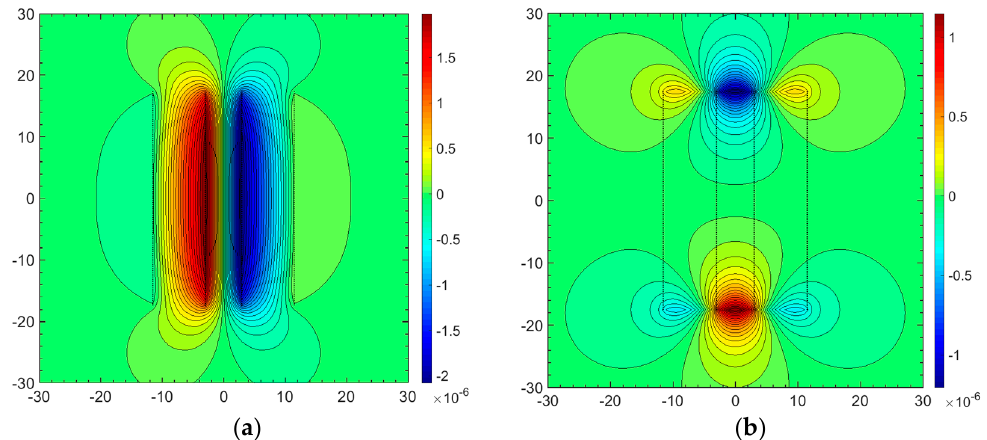
Figure 10. ( a ) Streamlines and stream function solution (color grades) for mud circulating down the drill string and up the annulus. Minor circulation occurs outside the annulus, which is an artifact of the model method. ( b ) Corresponding potential function solution. Length units are scaled in cm (both x-axis and y-axis).